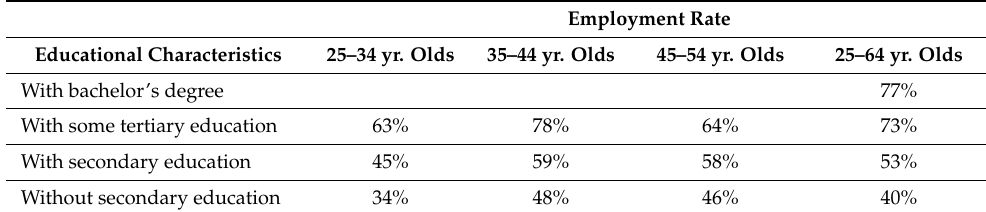
Table 2. Employment and educational attainment in South